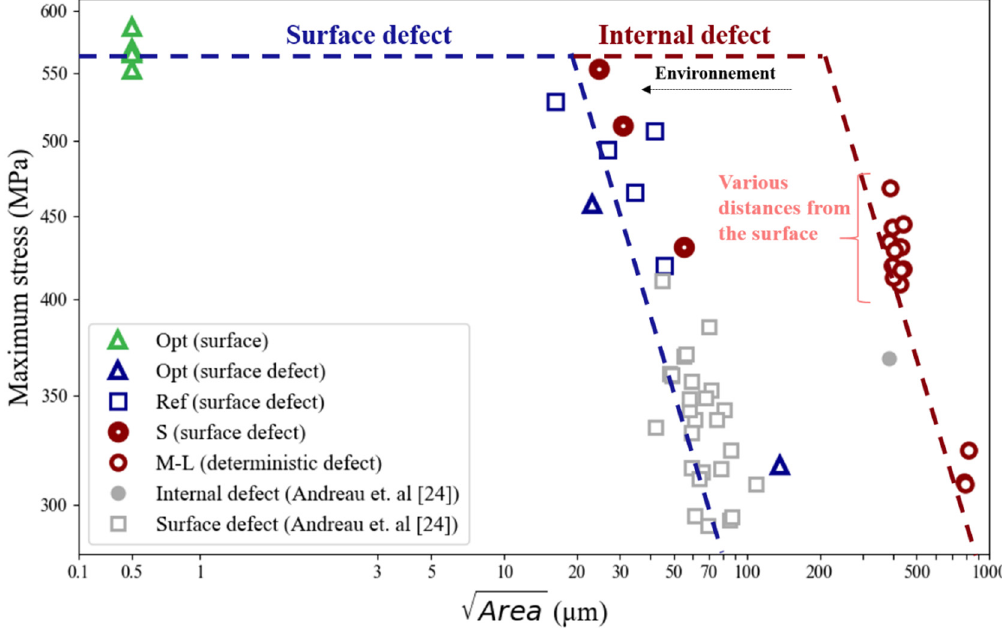
Figure 11. Kitagawa–Takahashi diagram with fatigue tests results [13].